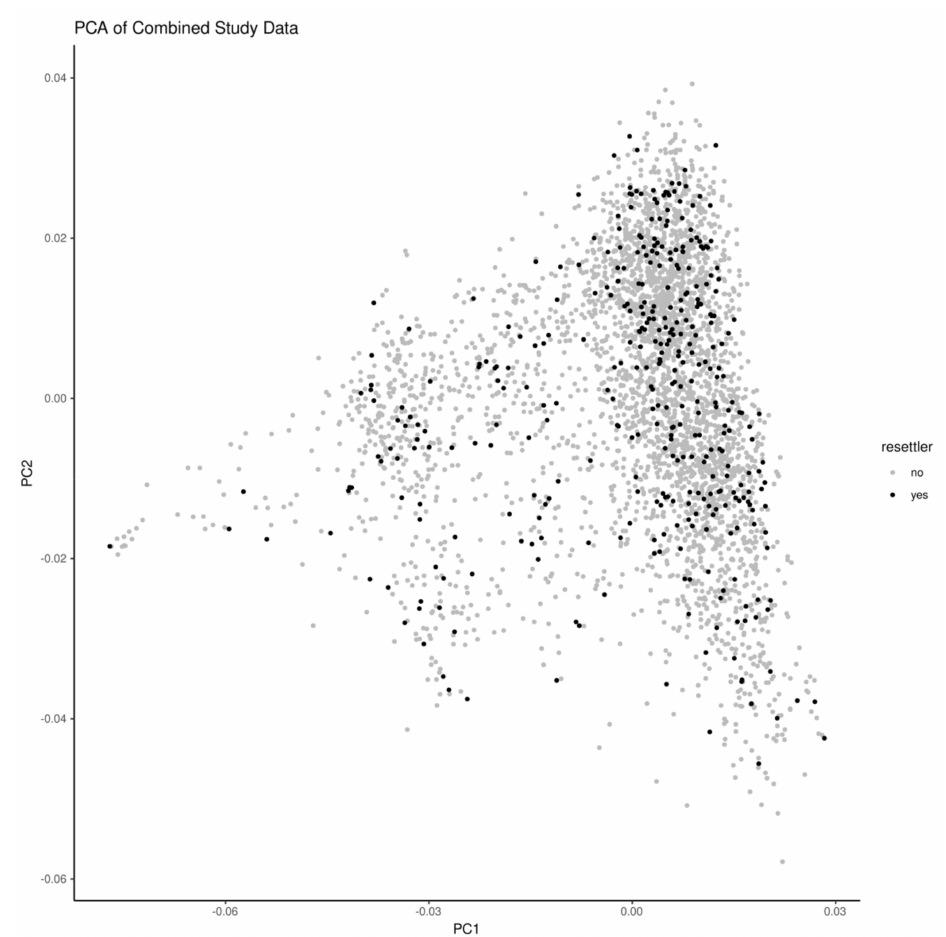
Figure 2. Principle component analysis (PCA) of the combined KORA and AMOR single nucleotide polymorphisms, with an indication of resettler status.